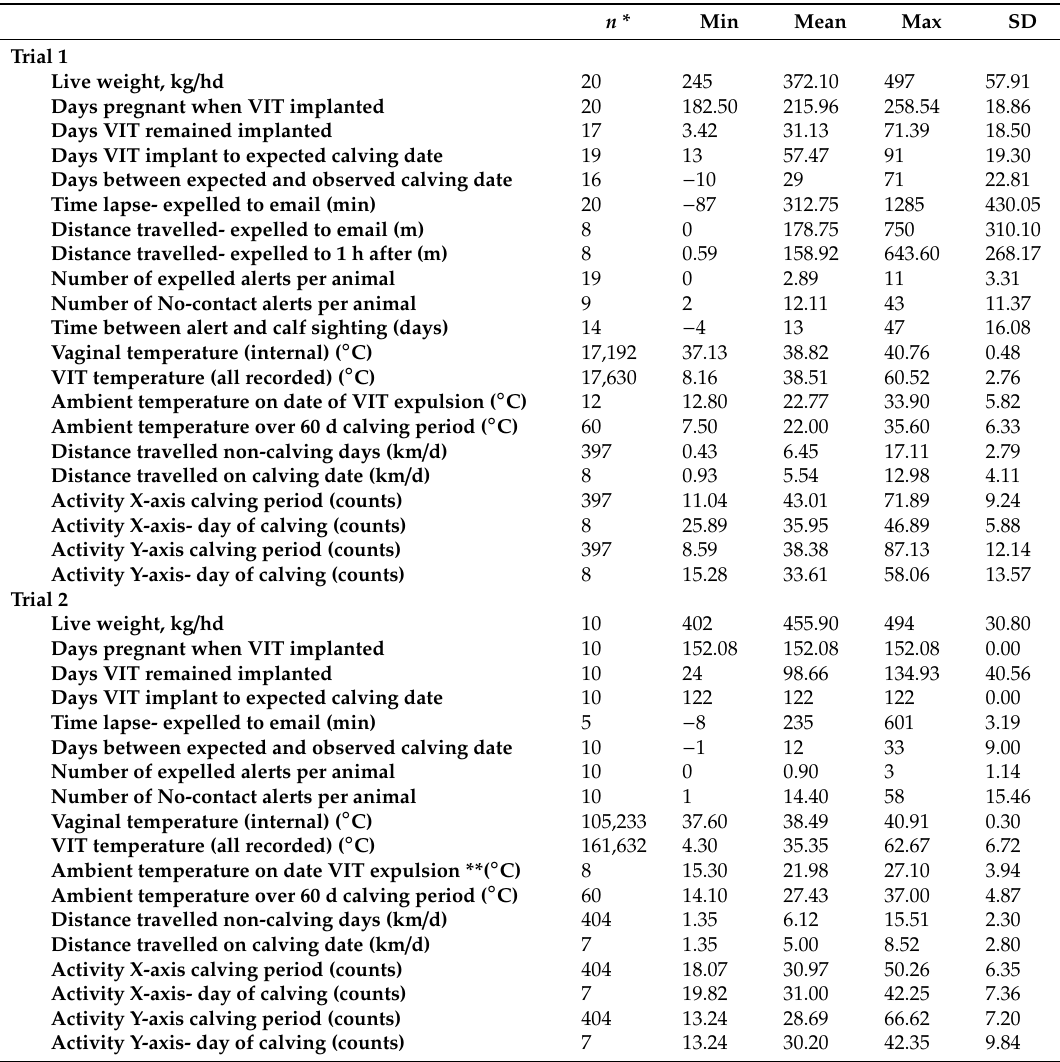
Table 2. Descriptive statistics for Trial 1 and 2 showing the number of observations, minimum mean and maximum values and the standard deviation for key measurements recorded in each trial. n * Min